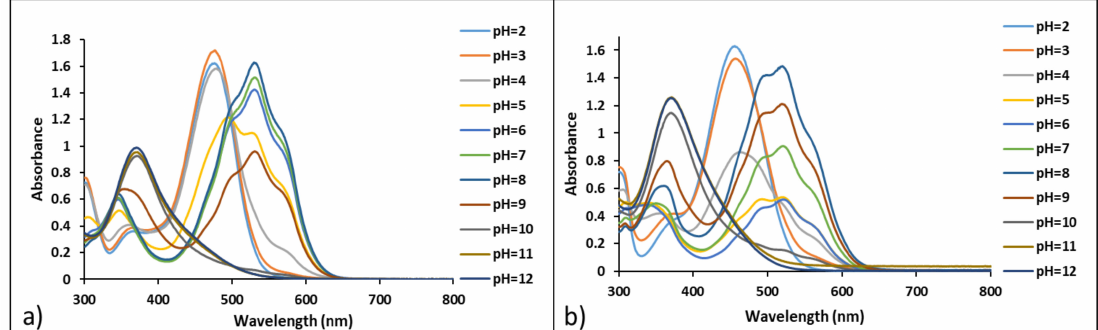
Figure 6. UV–VIS spectra of compounds 5 ( a ) and 7 ( b ) in different pH buffer solutions (7 × 10 − 5 M in methanol/water 1:14), 30 min after